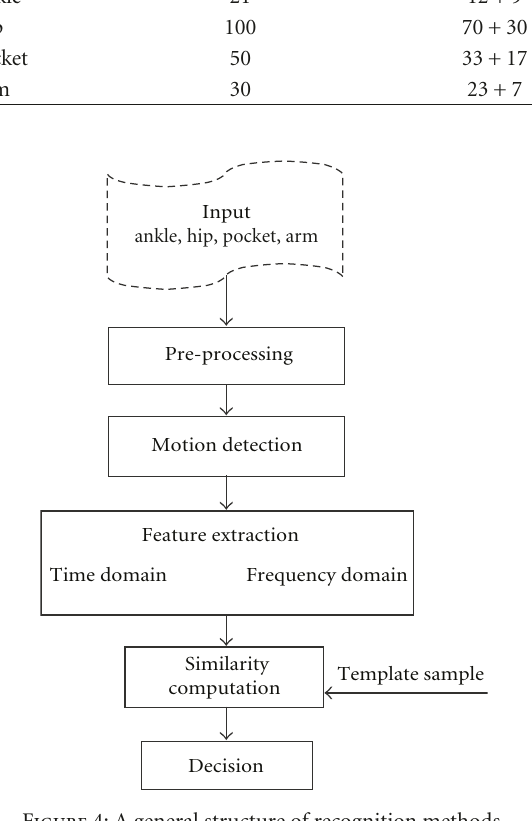
Figure 4: A general structure of recognition methods. Table 5: Summary of performances of our